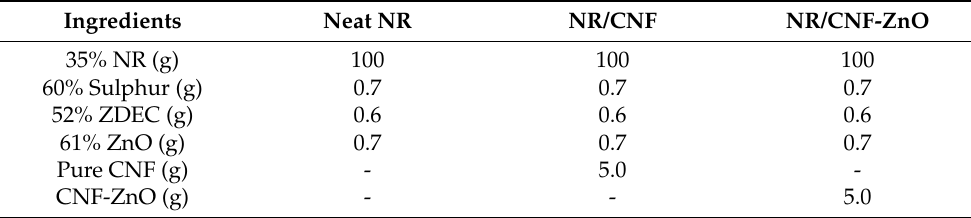
Table 1. Formulation of NR composite